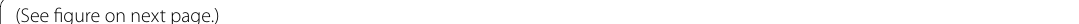
(See figure on next page.) Fig. 4 Detection of the effect of LAP and tLAP on liver fibrosis in HSC-T6 cells. A Detection of the effect of LAP and tLAP on cell proliferation by MTT. B Detection of the effect of LAP and tLAP on cell index by RTCA. C Detection of the mRNA expression α-SMA, Collagen I, Collagen IV, and Fibronectin in HSC-T6 cells. D Detection of the expression of α-SMA, Collagen I and Fibronectin in HSC-T6 cells. **P < 0.01 vs control group; ***P < 0.001 vs control group; # P < 0.05 vs TGF-β1 group; ## P < 0.01 vs TGF-β1 group; ### P < 0.001 vs TGF-β1 group; △ P < 0.05, TGF-β1 TGF-β1 LAP group; △△ P < 0.01, TGF-β1 tLAP group vs TGF-β1 LAP + + +